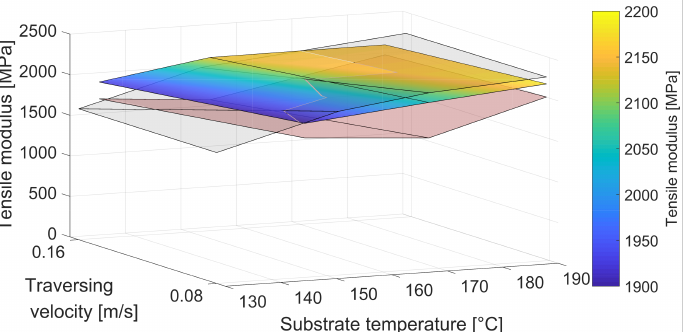
Figure 5. Tensile modulus of the heated specimens in the transverse direction with the reference tensile strength for unheated specimens at the same base temperature (red) and the achieved heated temperature